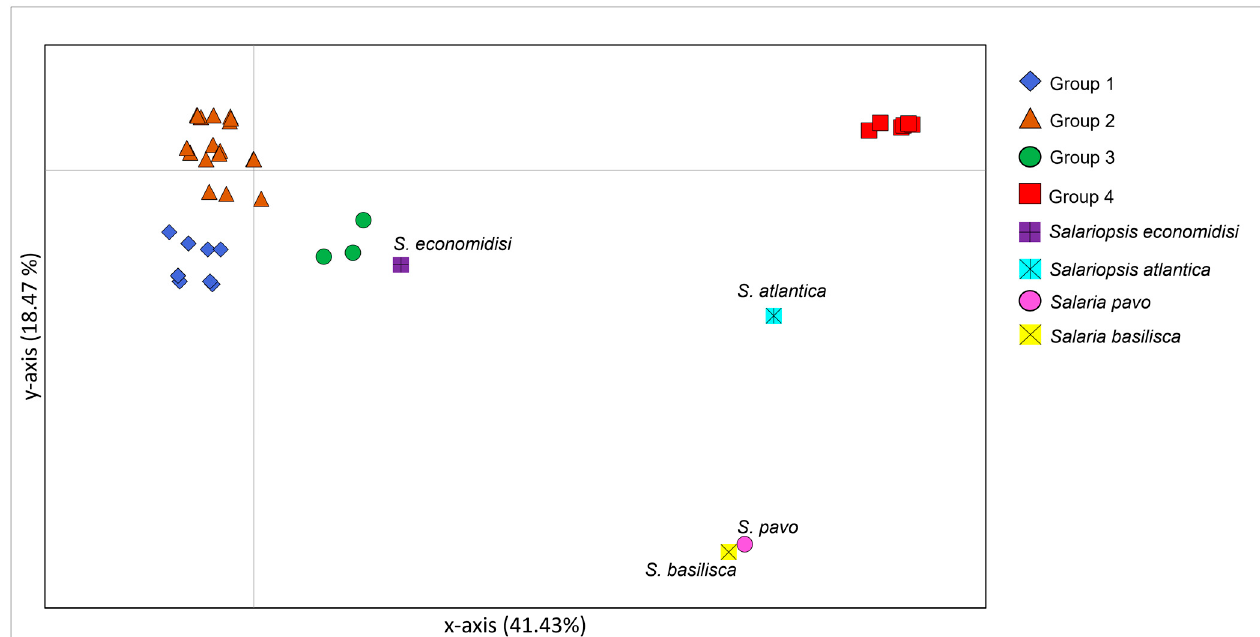
Figure 5. Principal coordinates analysis performed on the whole Control Region dataset. Bidimen- sional plot shows the genetic differentiation among specimens due to the nucleotide substitutions per site found in the dataset.